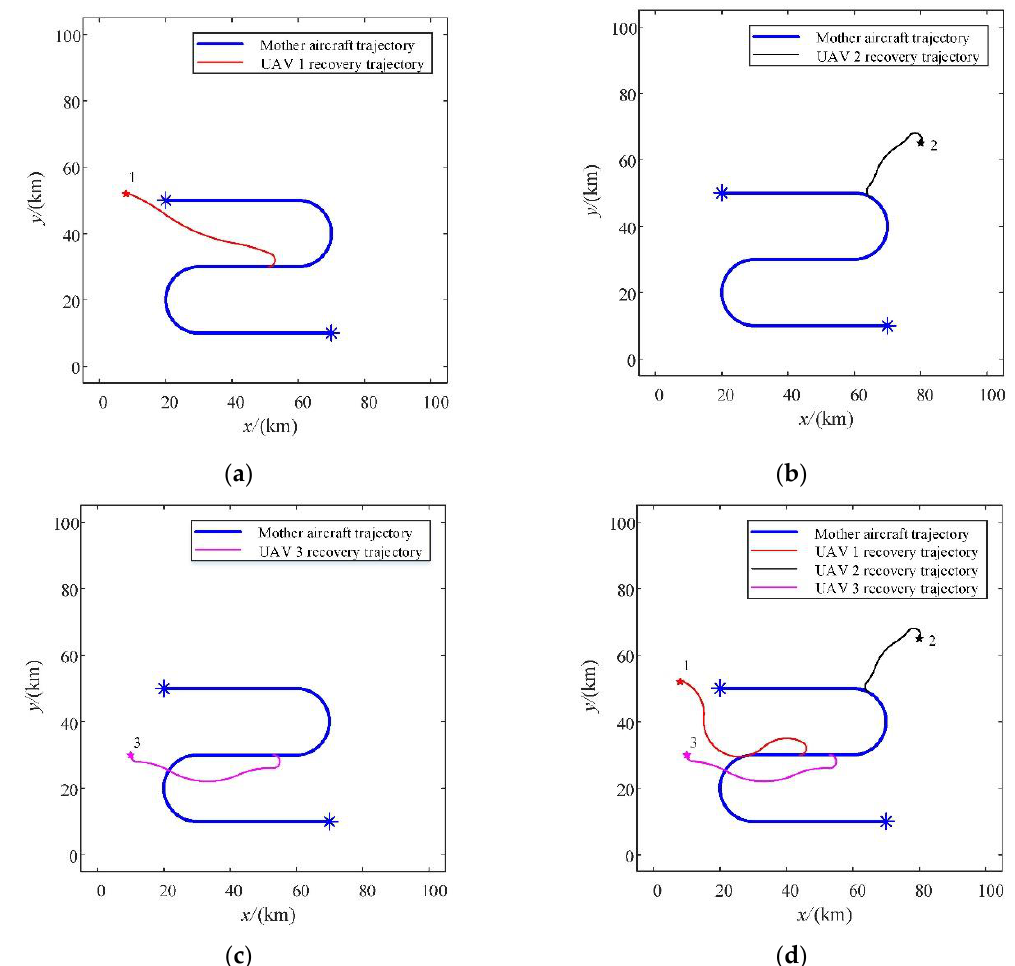
Figure 9. Simulation results of the recovery scheduling. ( a ) Recover UAV 1 individually; ( b ) Recover UAV 2 individually; ( c ) Recover UAV 3 individually; ( d ) Recover UAV 1, UAV 2, and UAV 3.